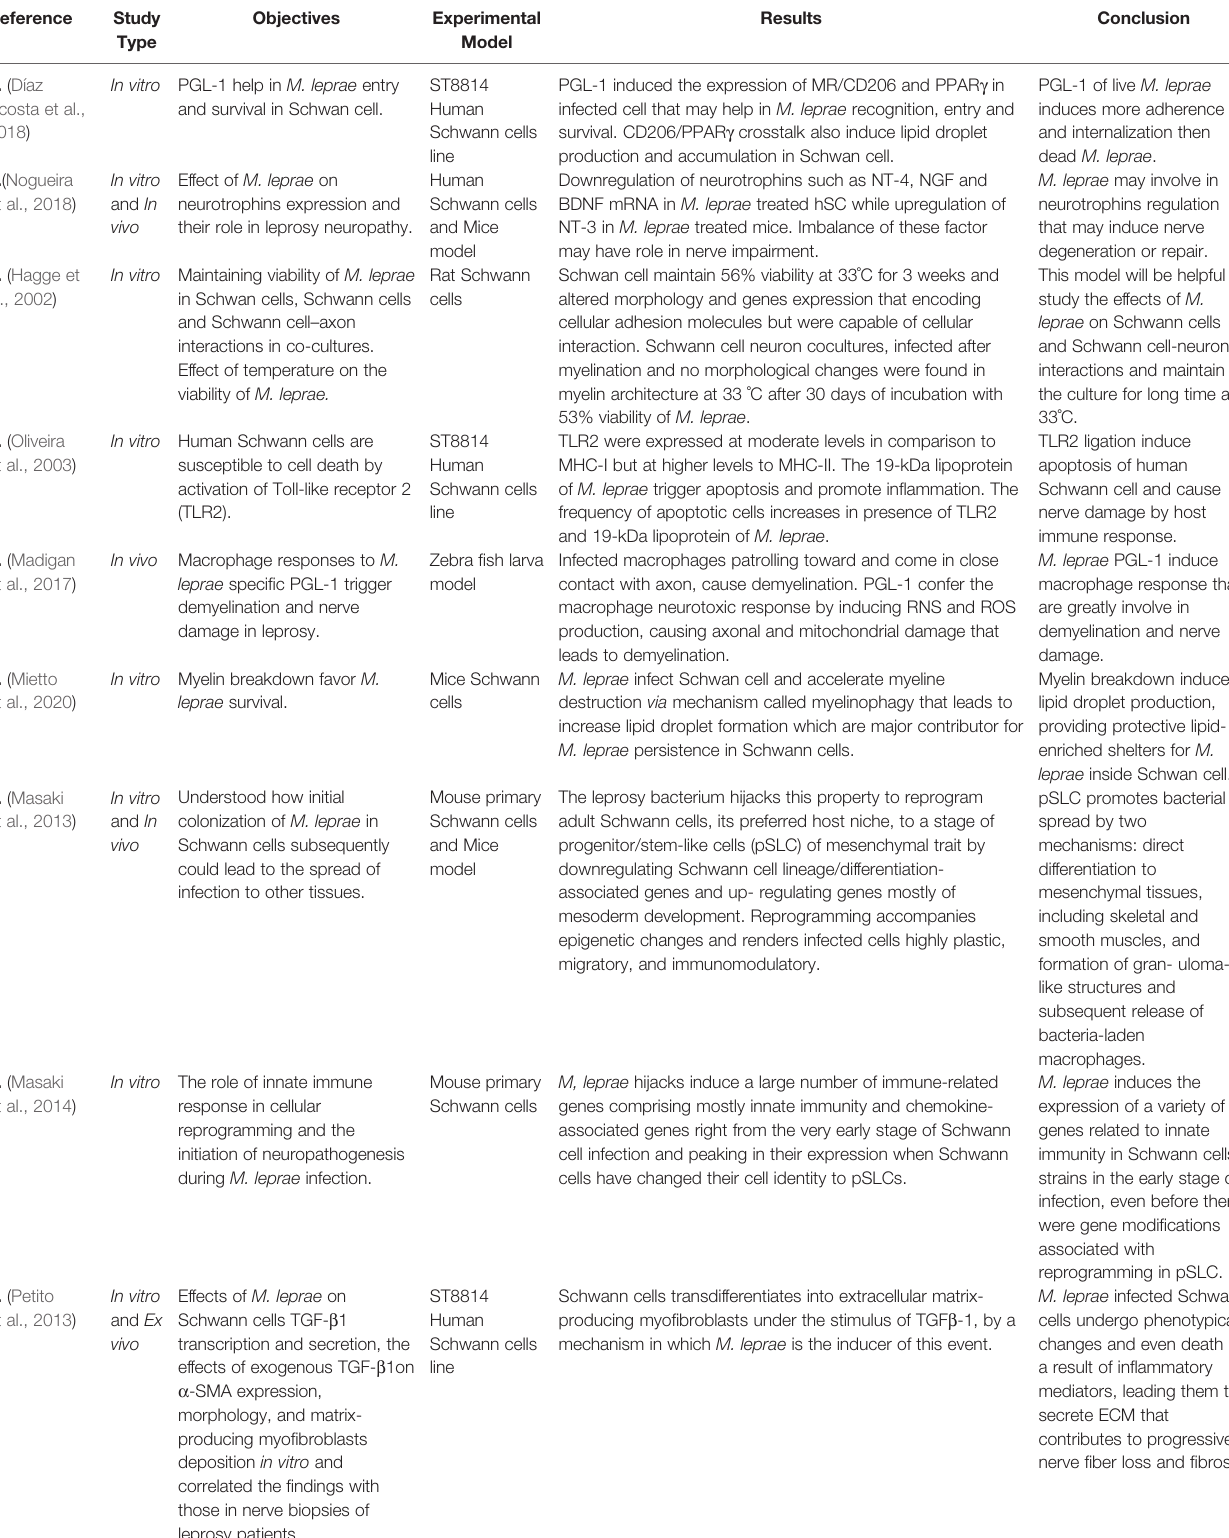
TABLE 1 | Cellular and molecular mechanisms of M. leprae interaction with peripheral nerve